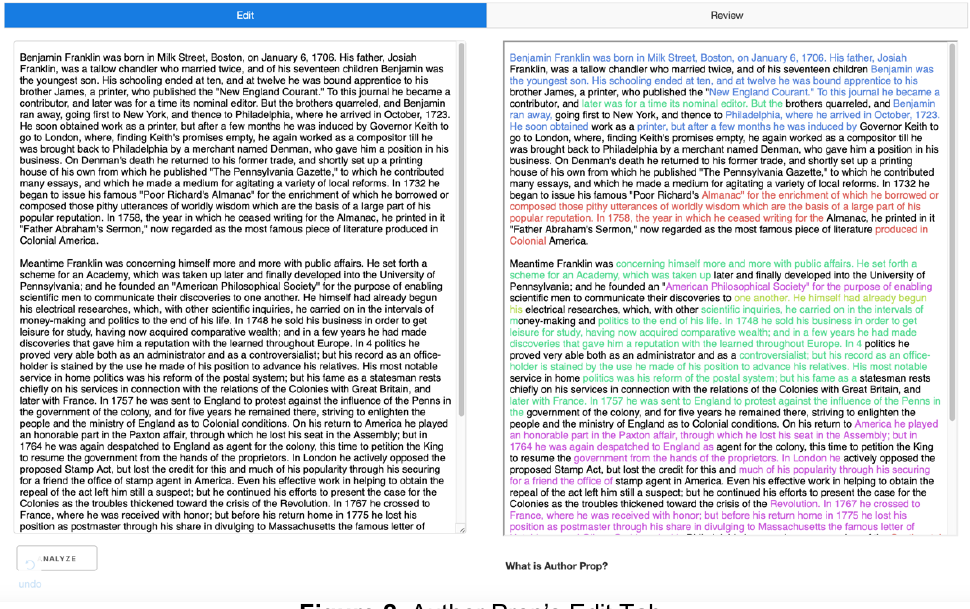
Figure 2. Author Prop’s Edit